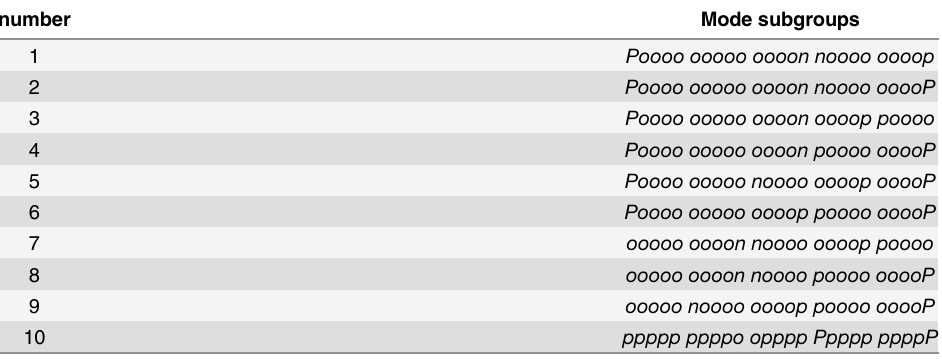
Table 5. Ten mode subgroups found by the K-plex